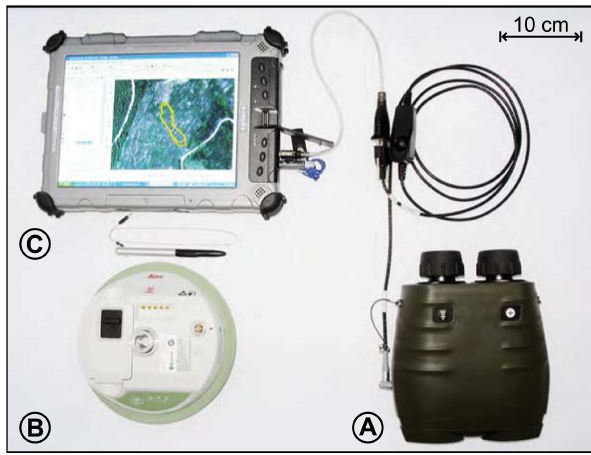
Fig. 1. Instruments used. (A) Vectronix VECTOR IV rangefinder binocular. (B) Leica Geosystems ATX1230 GG GPS/GLONAS receiver. (C) Xplore Technologies iX104C4 Rugged Tablet PC with ESRI’s ArcGIS release 9.3.1 and Leica Mobilematrix on ArcGIS release 3.1 software.